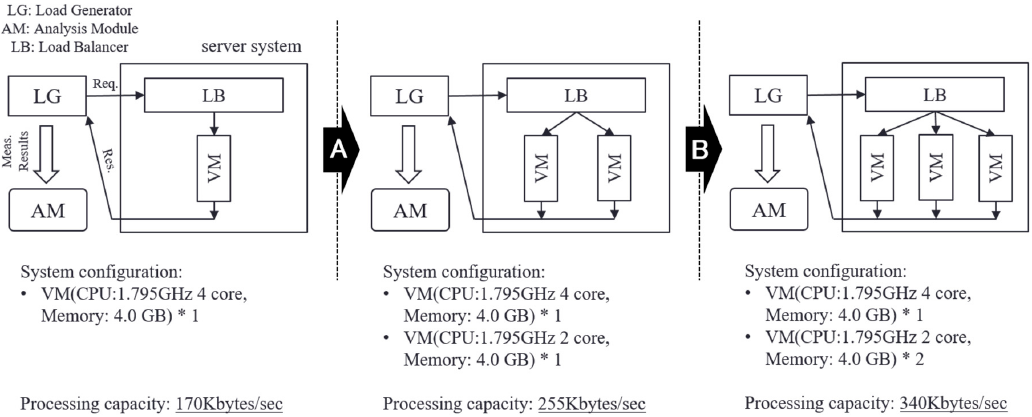
Figure 11. Changes in system configuration.